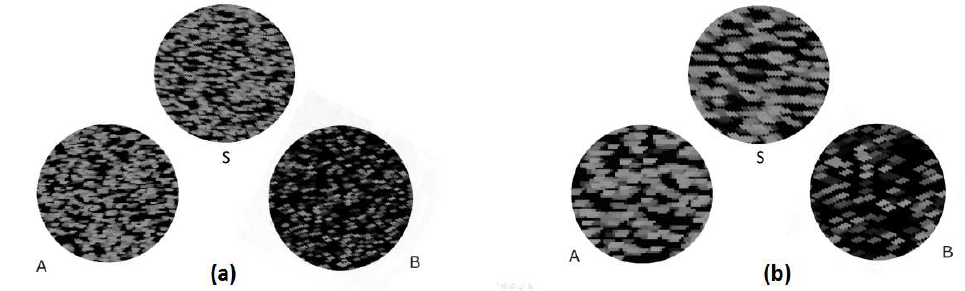
Figure 3. ( a ) Scene 3 and ( b ) Scene 4 (200% zoom of Scene 3) used in the experiment. The locations of Textures A and B are randomly on the left or